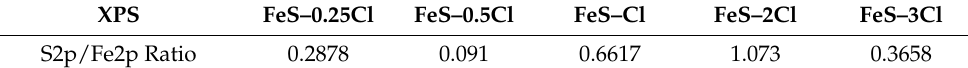
Table 10. S/Fe ratio.